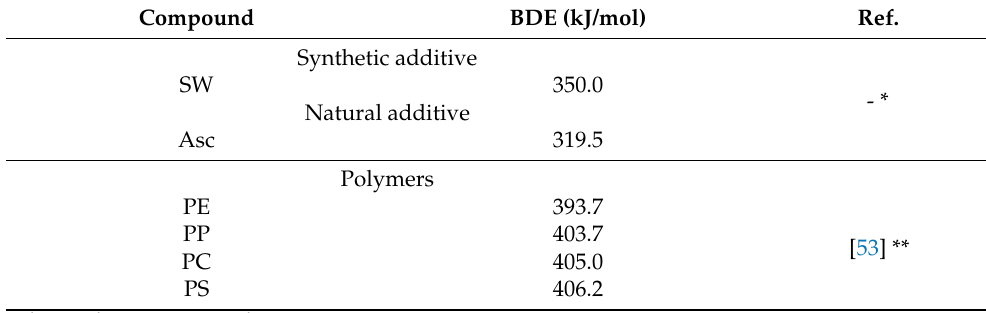
Table 3. Bond dissociation enthalpy (BDE) values of commonly used polymers such as polyethylene (PE), polysulfone (PS), polycarbonate (PC), and polypropylene (PP) along with the lowest BDE values (in kJ/mol) of the studied antioxidants, Santowhite (SW) and L-ascorbic acid (Asc) computed at the